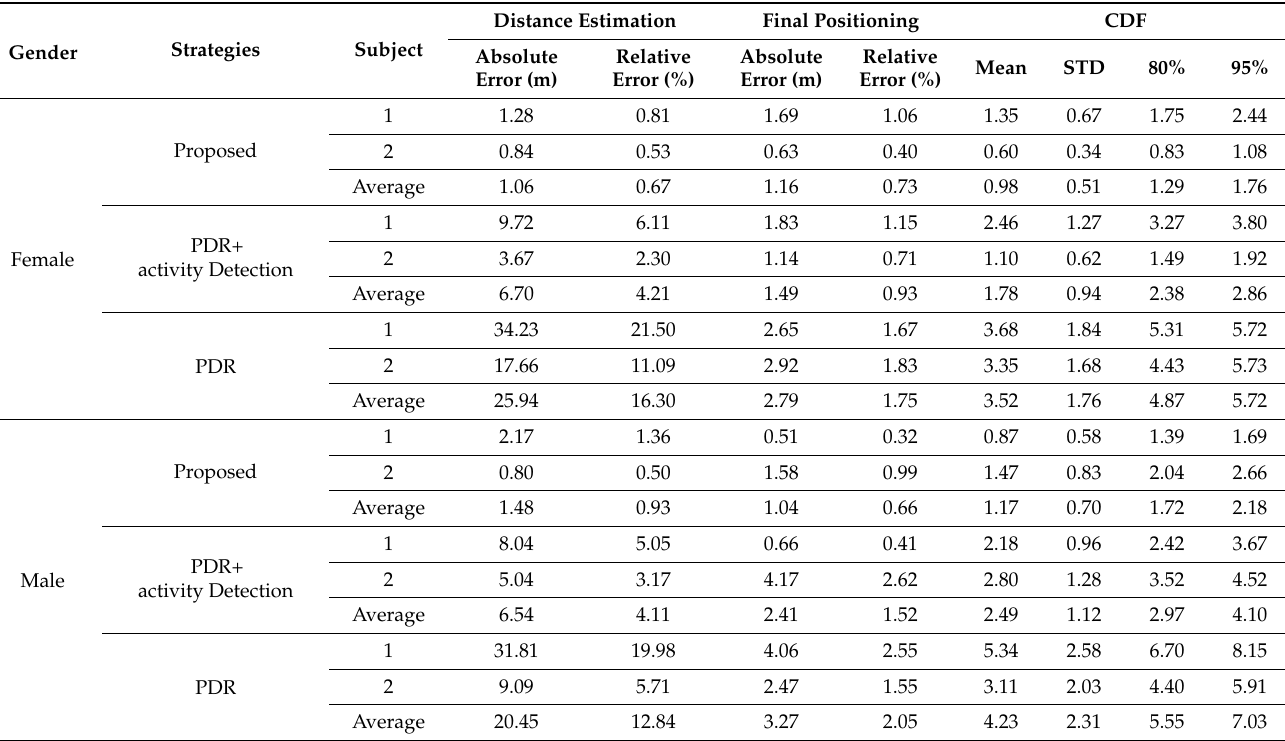
Table 11. Positioning results of the calling